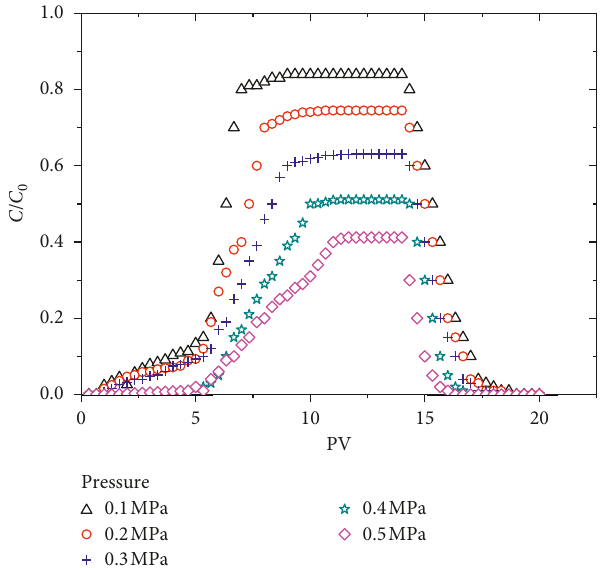
Figure 3: BTC of nZnO particles under different osmotic